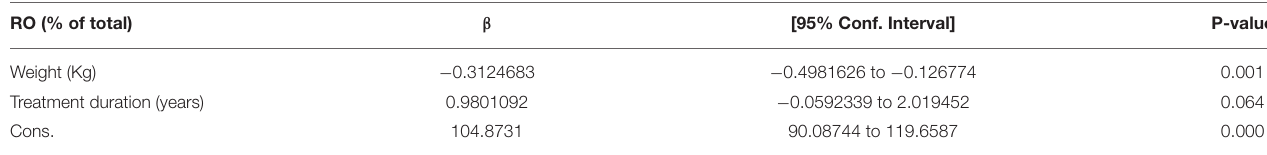
TABLE 5 | Multivariate analysis for receptor occupancy of α 4-integrin and BMI (variables are considered as continuous). RO (% of total) β [95% Conf. Interval] P-value Age (years) 0.1634503 Dose scheme (days) − 0.5334701 0.243 Treatment duration (years) 0.0029582 BMI (Kg/m2) − 1.398437 − 2.172268 to − 0.6246052 0.001